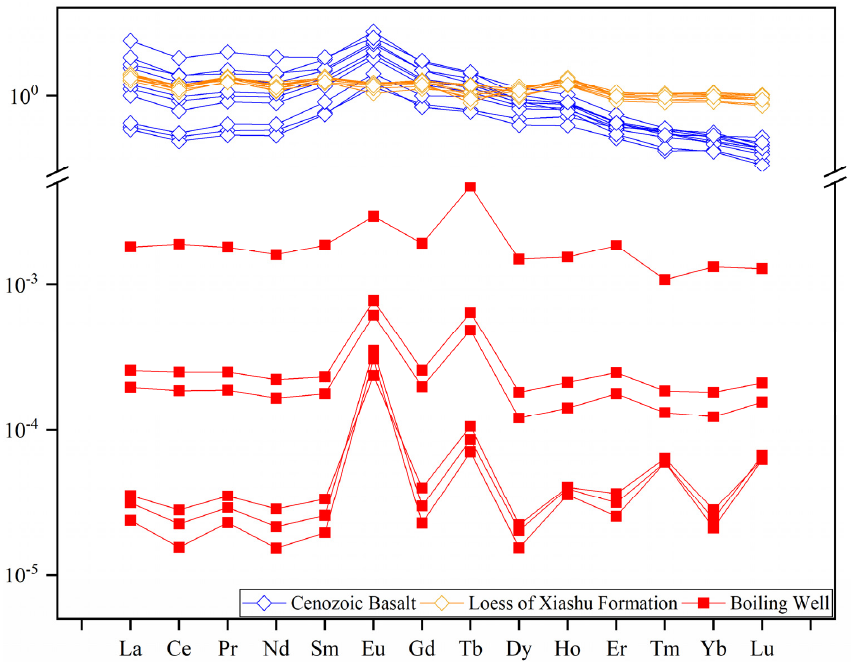
Figure 8. NASC-normalized REE patterns of Boiling-Wells, Cenozoic basalt, and Loess of the Xiashu Formation.